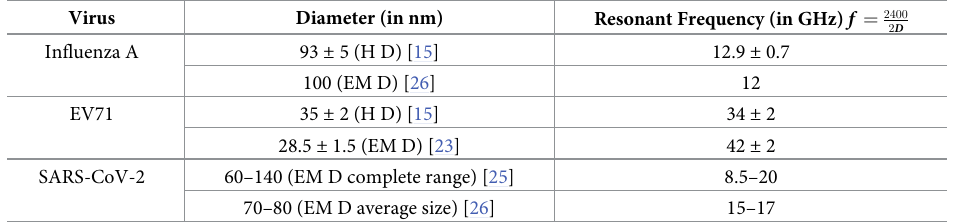
H D and EM D indicate hydrodynamic and electron microscope diameters